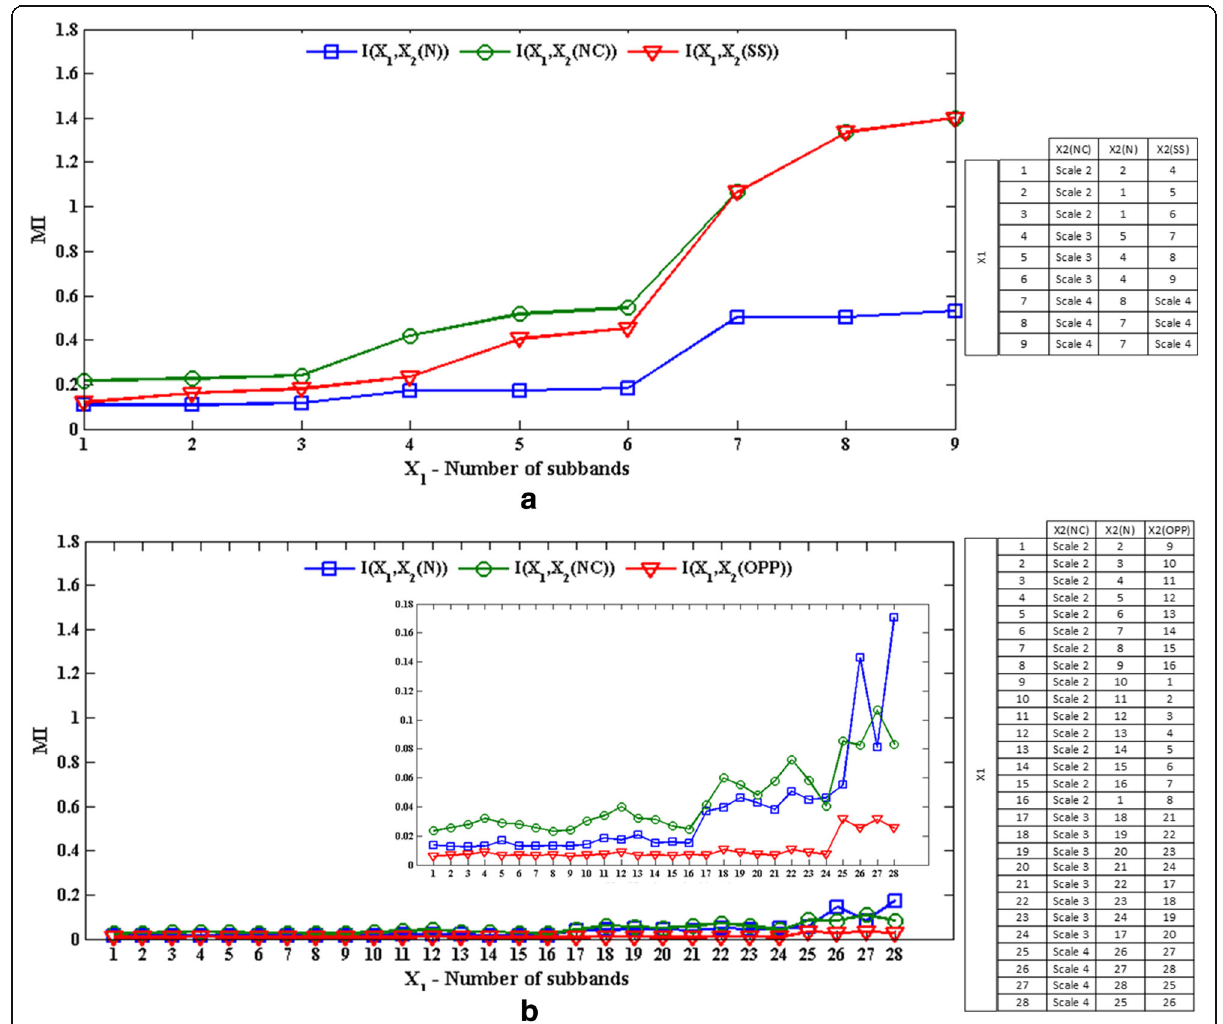
Fig. 4 MI for a SWT and b